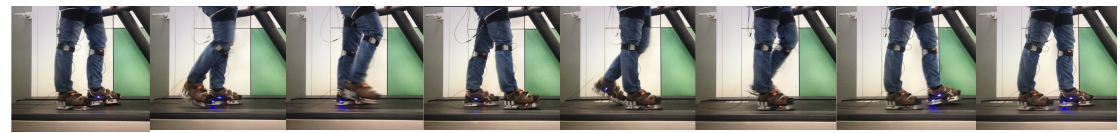
Figure 4. Task T4, Sequence 2: walking on a